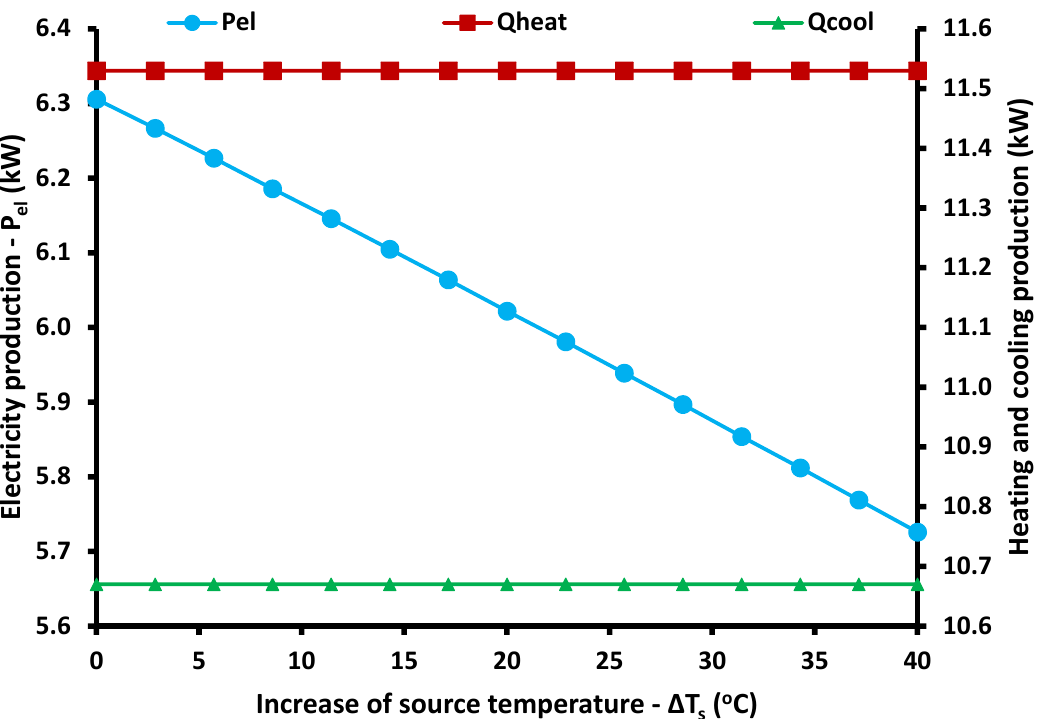
Figure 8. Electricity, heating, and cooling for different heating source temperature difference values.